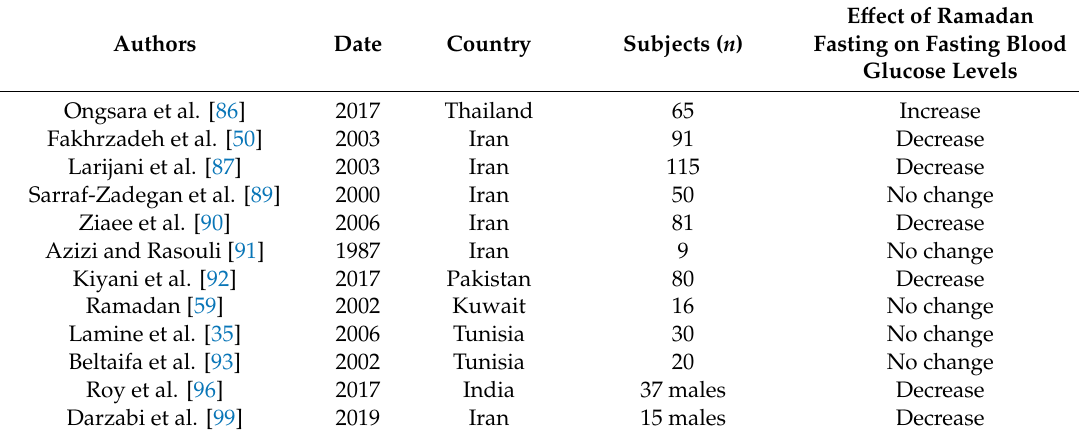
Table 5. E ff ect of Ramadan fasting on fasting blood glucose levels in healthy